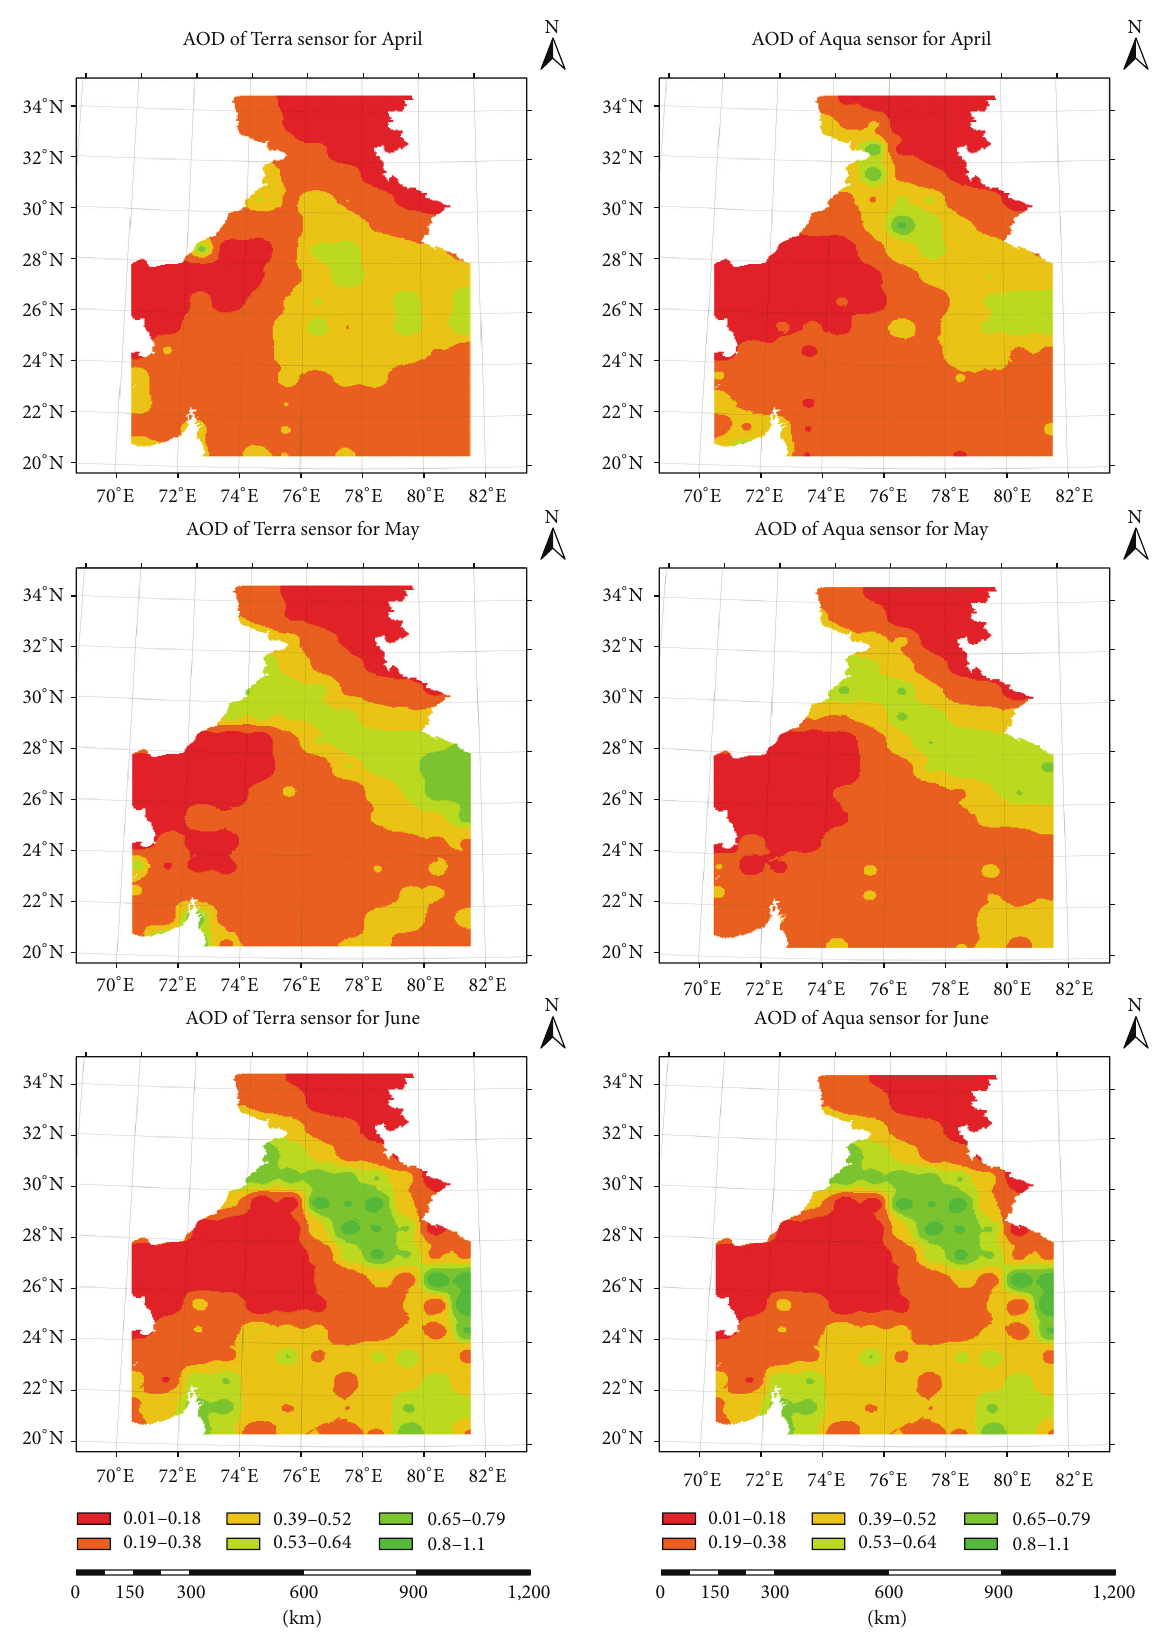
Figure 6: Spatial distribution of aerosol optical depth values over the region using MODIS Terra and Aqua data during April to June